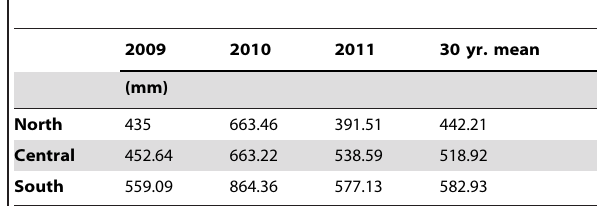
Table 2. Cumulative precipitation from April through October by location and year, for comparison with other